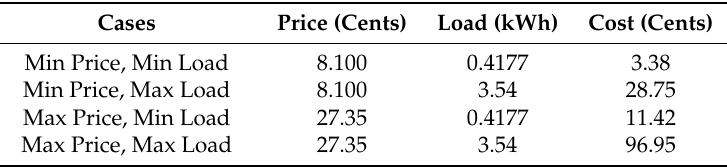
Figure 11. Feasible region for multiple OTIs using RTP. Table 10. Possible cases: OTI 15-min using RTP.